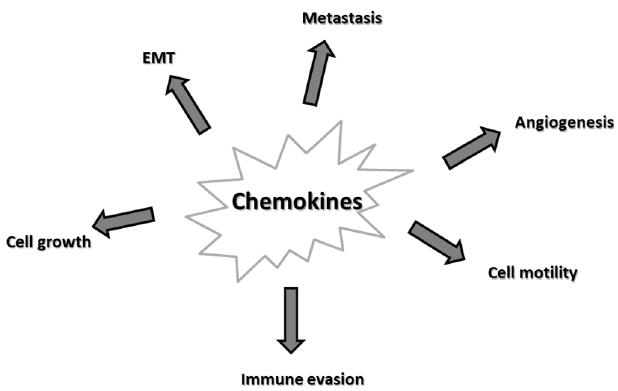
Figure 2. Major e ff ects of chemokines on cancer. Epithelial-mesenchymal transition Figure 2. Major effects of chemokines on cancer. Epithelial ‐ mesenchymal transition (EMT).